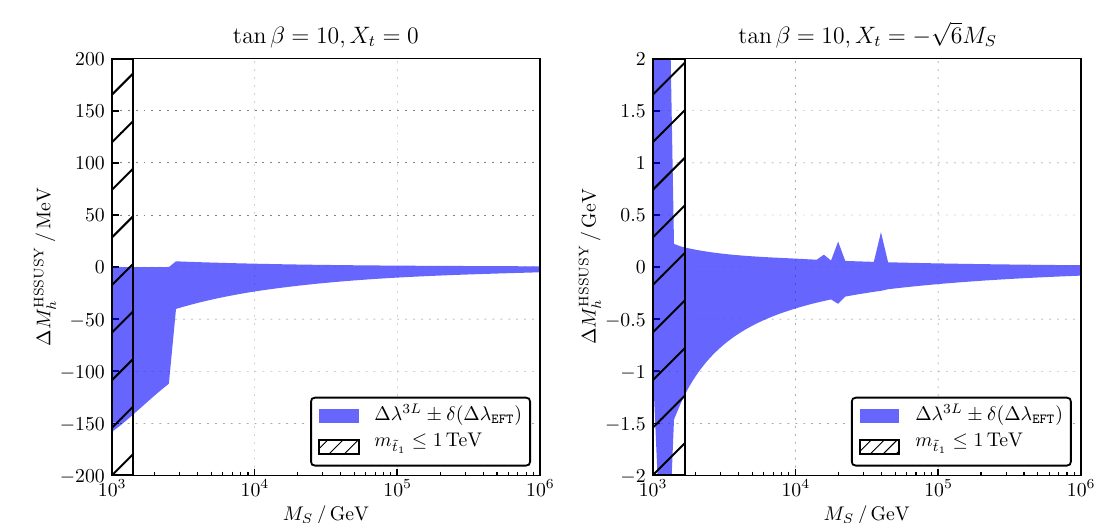
± δ(((cid:6)λ ) ) is included, with respect to the tion ((cid:6)λ EFT ) ¯ α 2 EFT ¯ a 2 ¯ α 2 ¯ a 2 t t s s two-loop calculation. In the hatched region there is m ˜ t for at least one of the scanned parameter